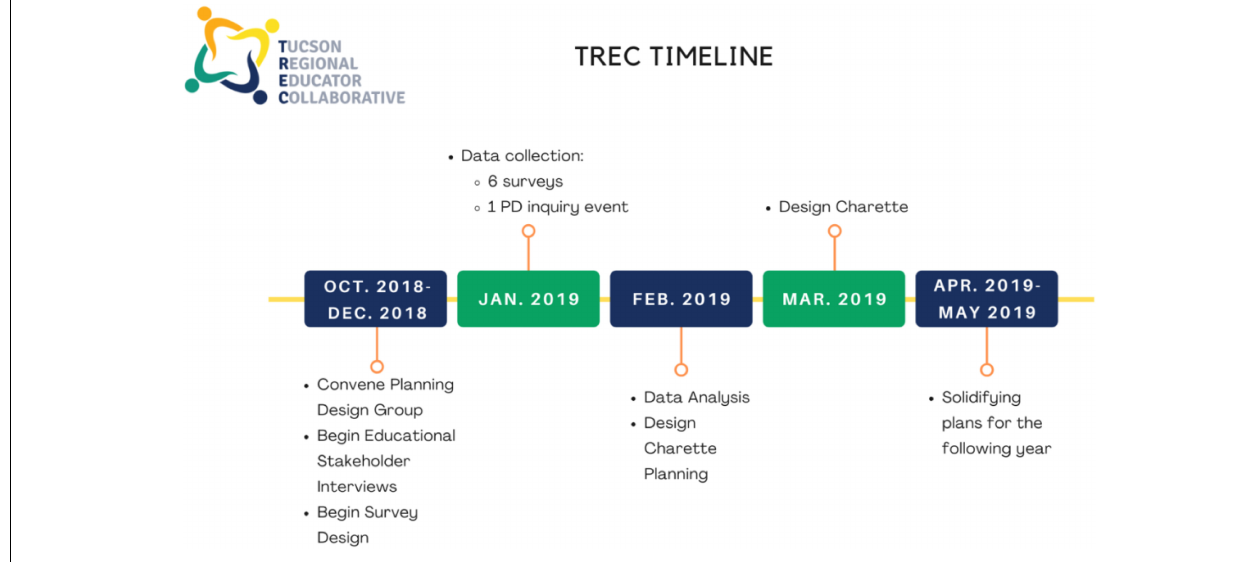
FIGURE 1 | Planning and design